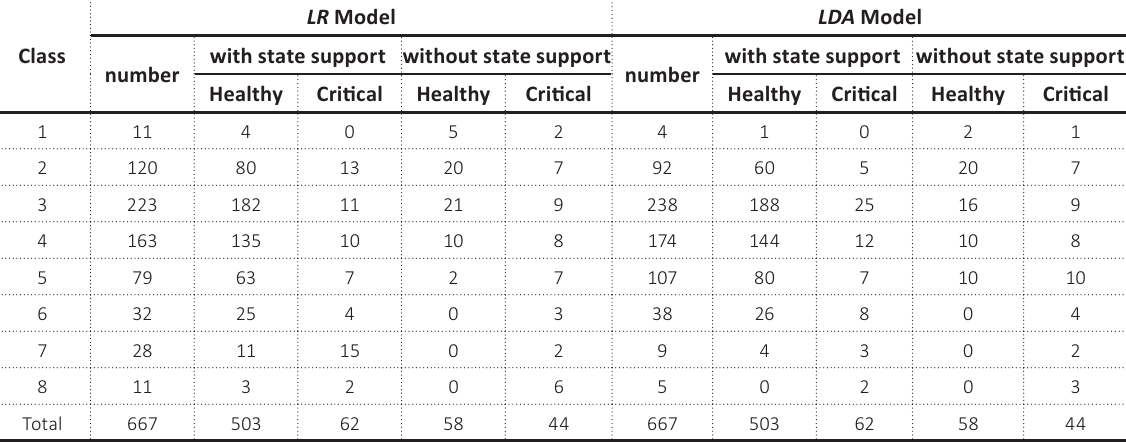
Table 2. Classification according to state support Class